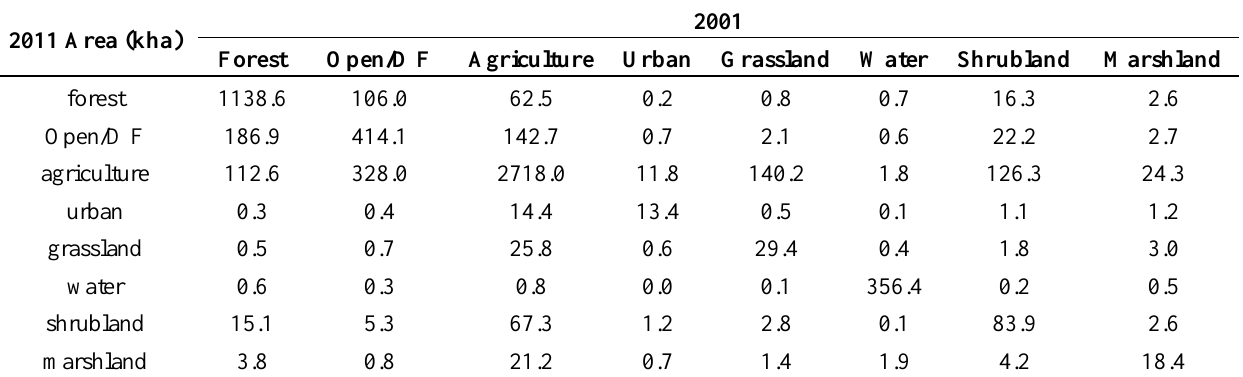
Table 8. Matrices for land cover changes (kha) from 2001 to